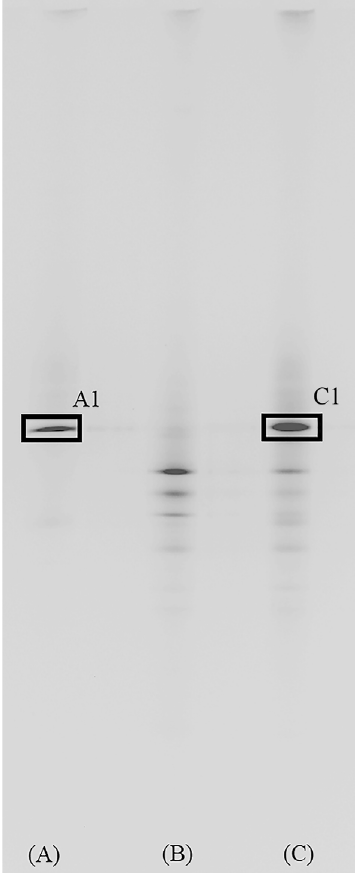
Figure 2. Denaturing gradient gel electrophoresis of rumen microbiota isolated at 12 h post feeding from in vivo study. (A) DNA from Rhodobacter sphaeroides (R. sphaeroides) pure culture, (B) control TMR, (C) 0.5% R. sphaeroides supplemented TMR. A1 (boxed) indicates the band amplified with photosynthetic reaction center M subunit (pufM) gene of R. sphaeroides and C1 (boxed) had 98.4% similarity with R. sphaeroides.